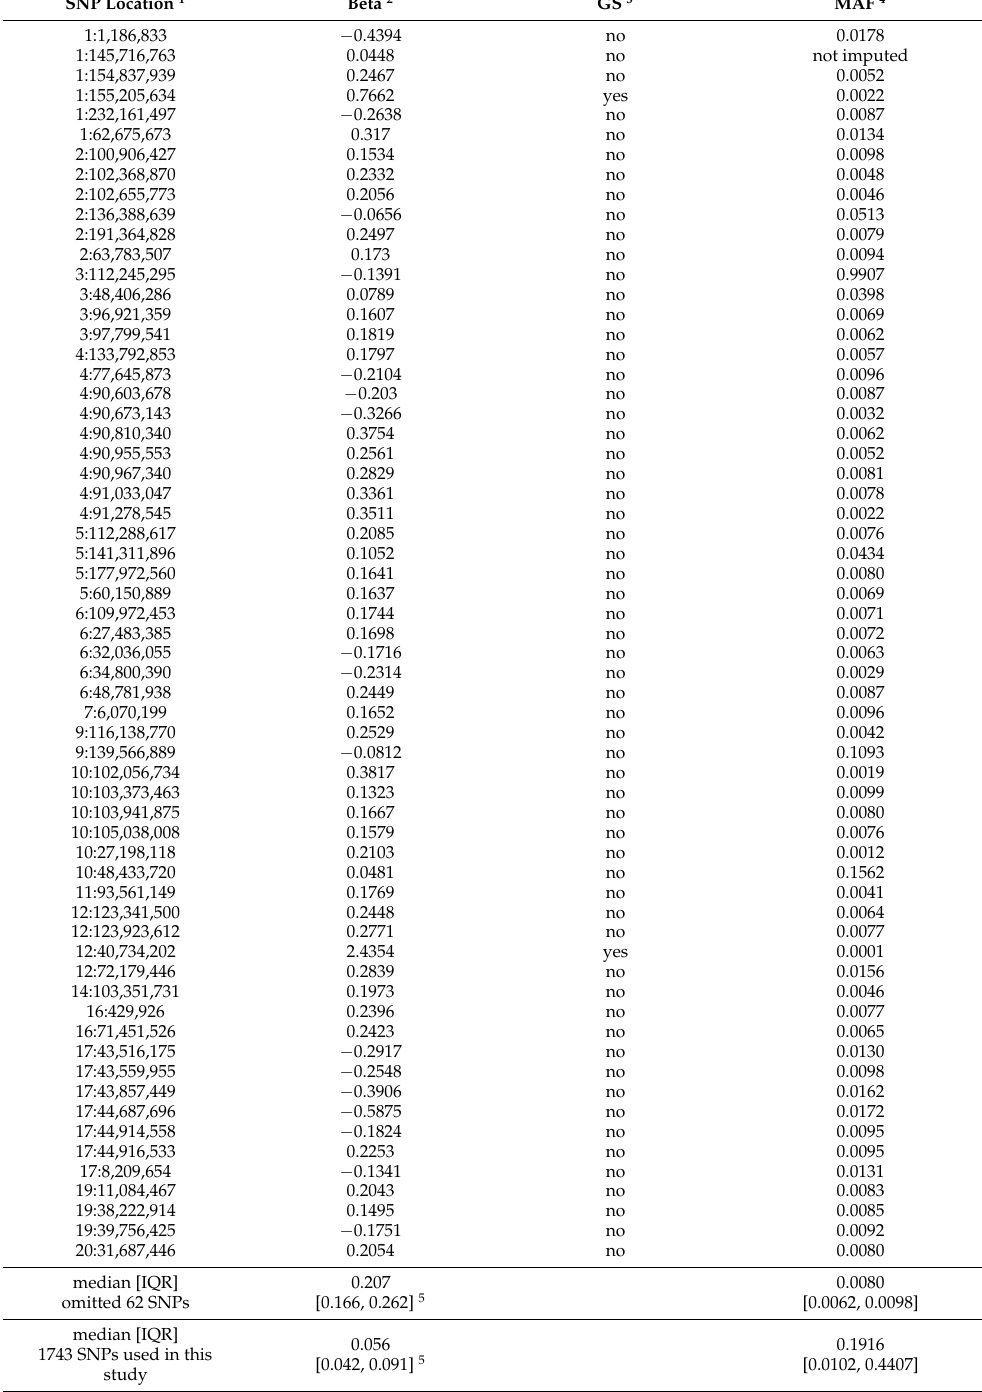
Table A2. SNPs omitted from